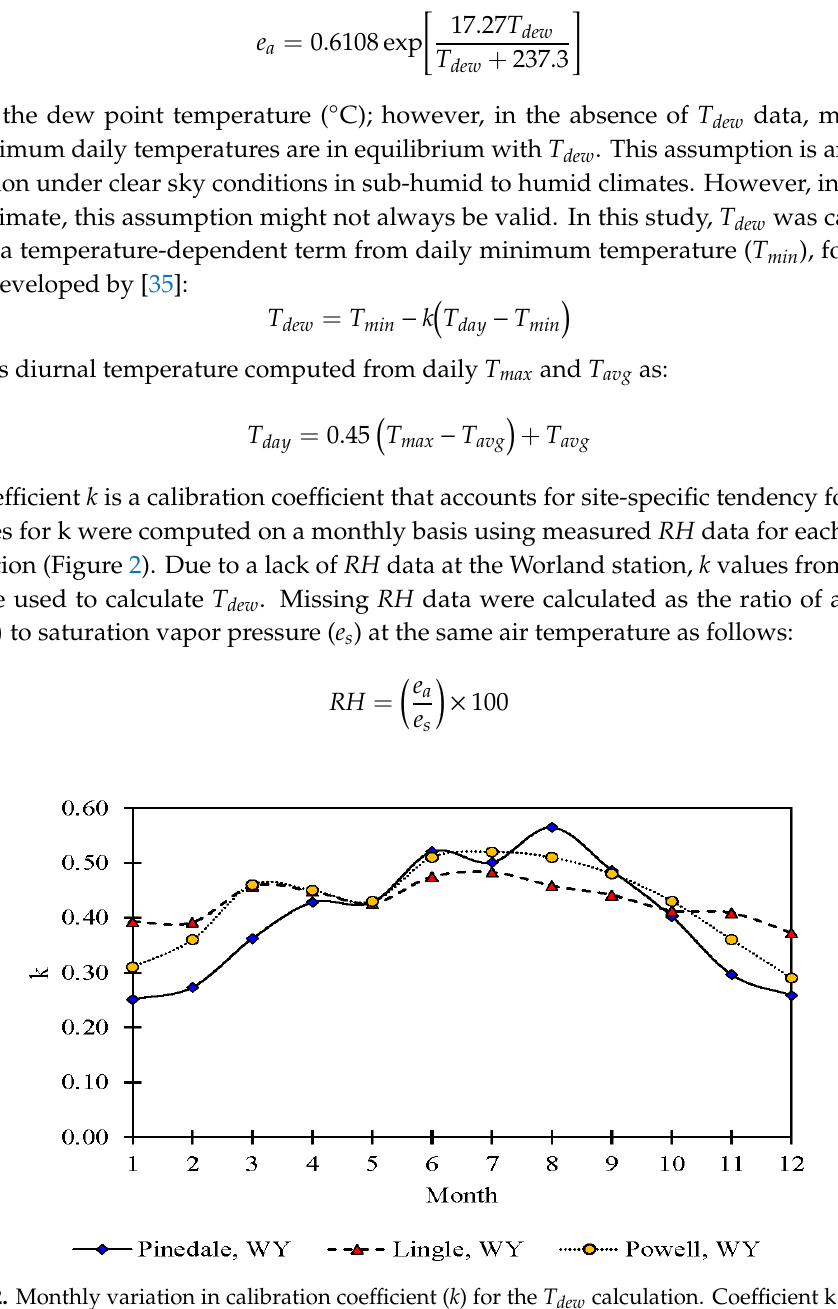
Figure 2. Monthly variation in calibration coefficient ( k ) for the T dew calculation. Coefficient k account for the site-specific tendency of relative humidity to remain below 100%.